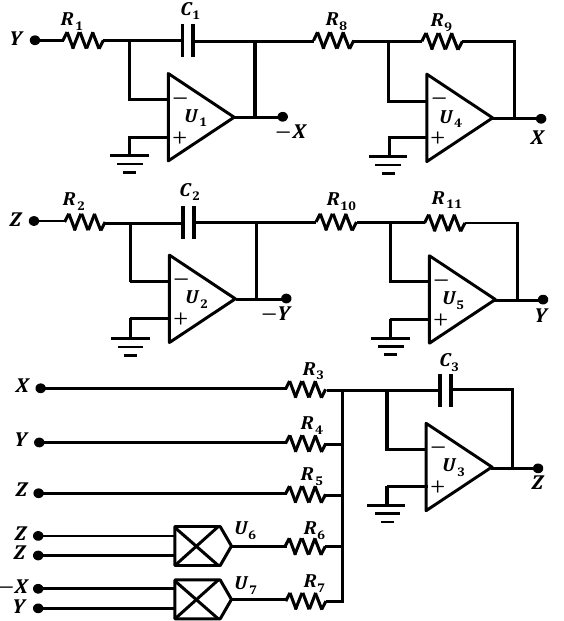
Figure 10. Circuital implementation of the hidden chaotic system (28) with a stable equilibrium at the origin.